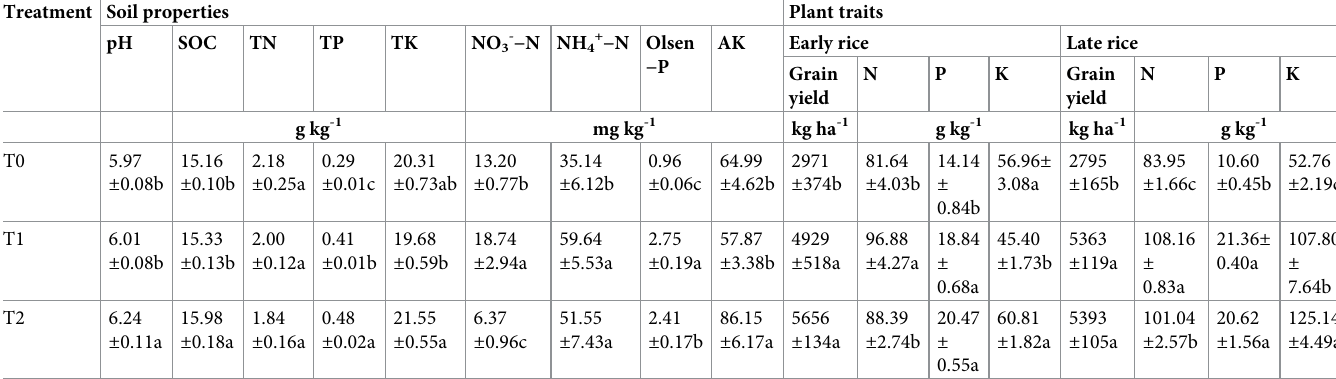
Table 2. Soil properties and plant traits as influenced by fertilization and irrigation in 2018. Treatment Soil properties